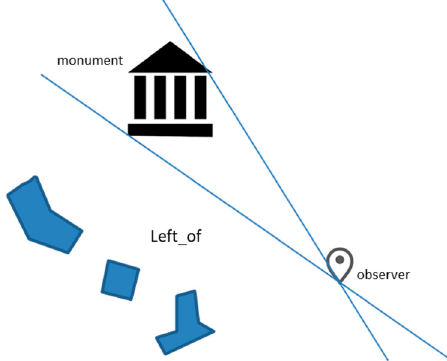
Figure 8. Finding buildings on the left side of the monument from the observer point of view.